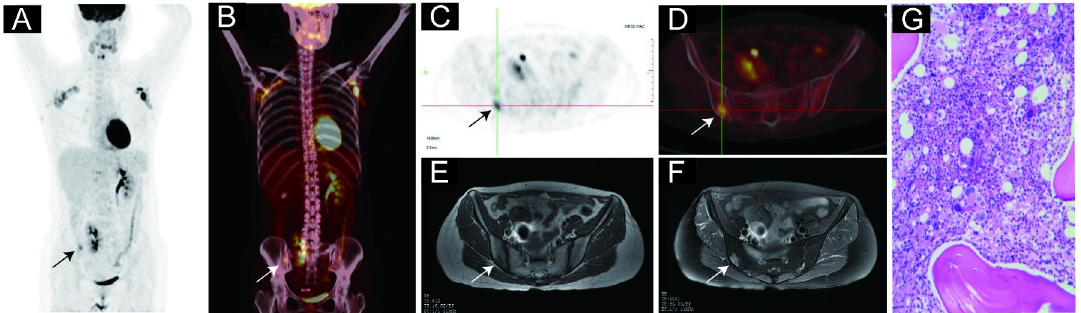
Fig 3. Representative case of a 46-year-old female diagnosed with diffuse large B-cell lymphoma. (A) and (B): Coronal positron emission tomography (PET) and PET-computed tomography (CT) images, respectively, revealing a lesion with an increased focal 18 F-fluorodeoxyglucose uptake in the right posterior superior iliac spine. (C) and (D): Transverse view of the same process as in panels A and B, respectively. (E): The right posterior superior iliac spine exhibiting low signal intensity on the T1-weighted, transverse pelvic magnetic resonance image (MRI). (F): The right posterior superior iliac spine exhibiting high signal intensity on the fat-suppressed, T2-weighted, transverse pelvic MRI. (G): Hematoxylin and eosin staining confirmed bone marrow involvement in this patient. The patient’s blood glucose level before the PET/CT imaging was 4.9